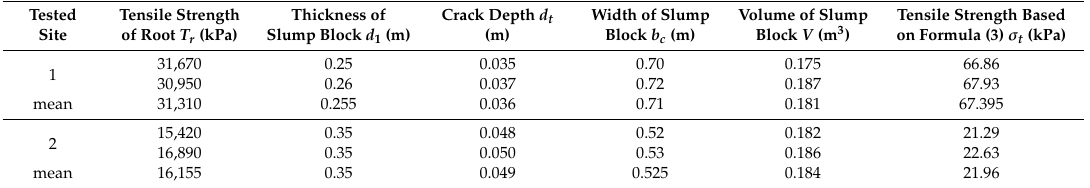
Table 3. Physical and mechanical properties of the soil-root mixture at the two sites. Tested